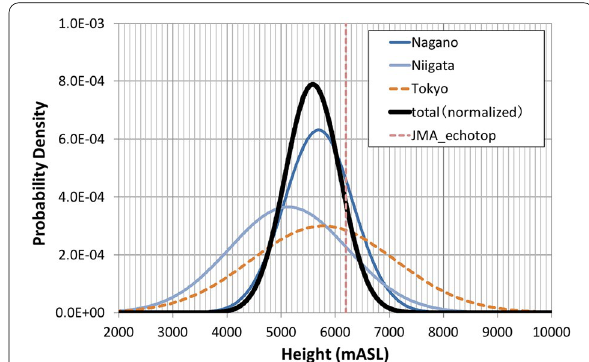
Fig. 3 Probability densities of plume height estimated for each radar (thin colored curves) and composite plume height (thick black line). The pink, dashed vertical line at 6200 m ASL indicates radar echo height determined by JMA